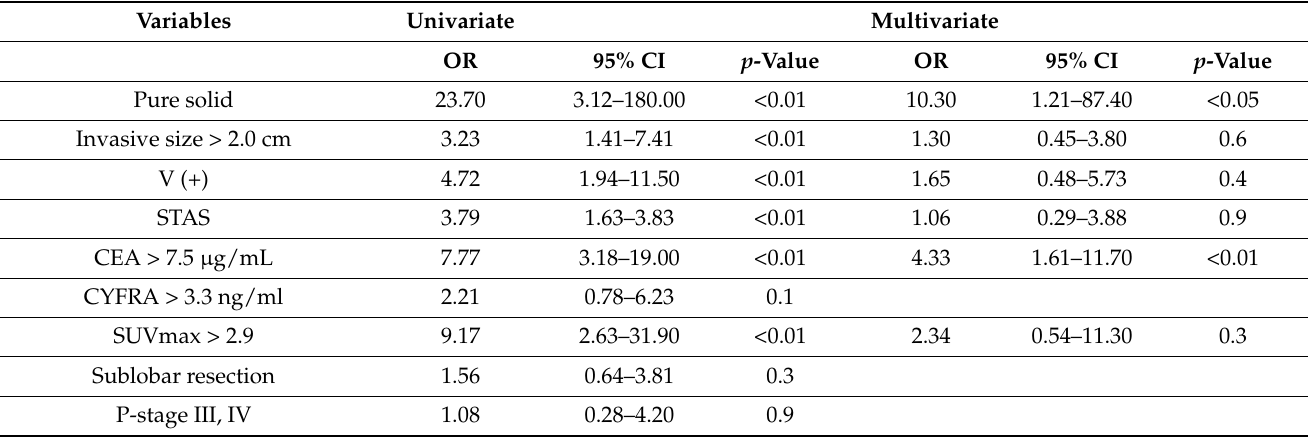
Table 3. Logistic regression analysis of detecting clustered circulating tumor